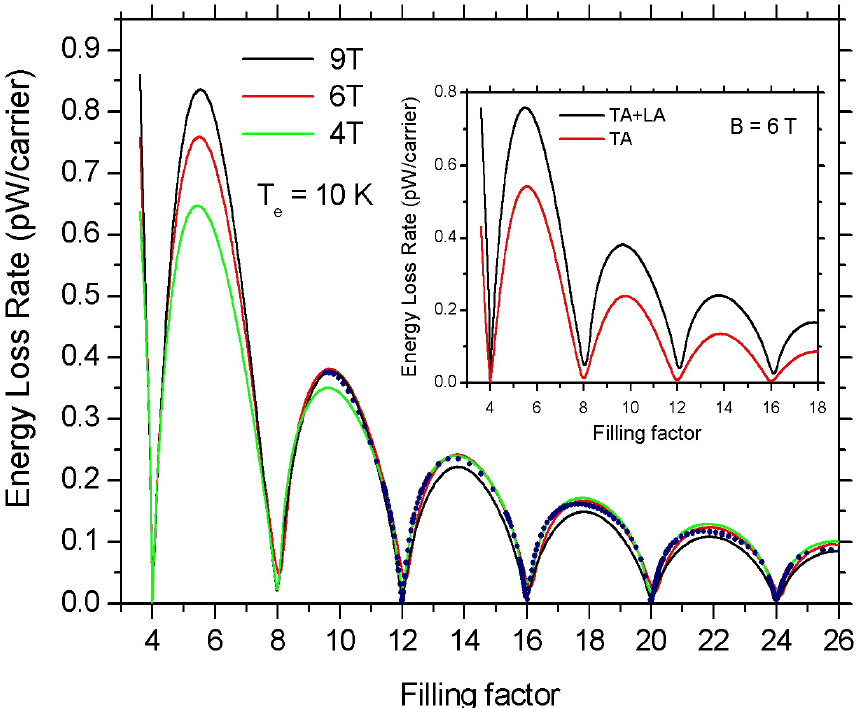
Figure 7. Magnetoscillations of ELR as a function of filling factor, ν , at T e = 10 K. The green, red, and black solid lines correspond to B = 4,6, and 9 T, respectively. Here the ELR oscillations as a function of ν are controlled by the variation of the electron density. For comparison the blue dots show the calculated ELR values when B varies between 0.7–5.5 T and n s = 10 16 m − 2 at T e = 10 K. In the inset, the red solid line is the contribution to the total ELR (solid black line) due to electron scattering by TA phonons at B = 6 T. ( γ = 2 meV/T 1/2